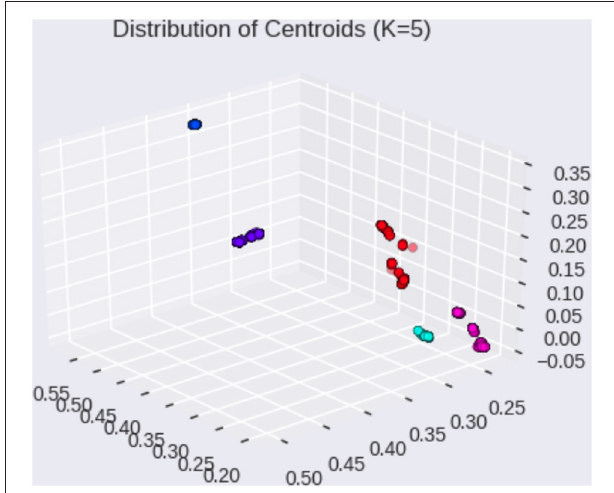
FIGURE 1 | Distribution of cluster centroids on LIWC question vectors (1,000 EM